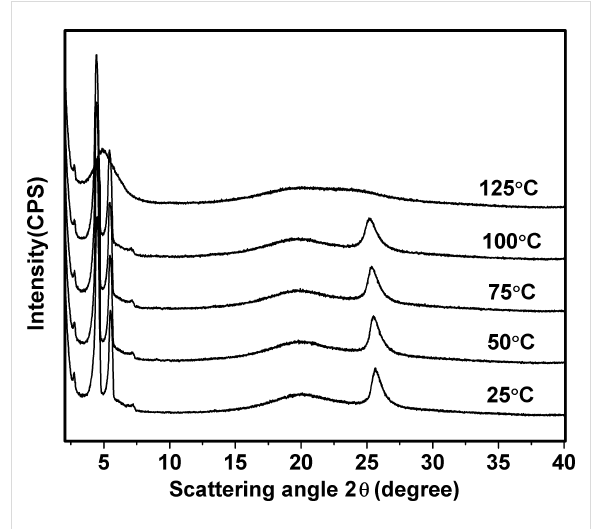
Figure 5: X-ray diffraction profiles of 4 at different temperatures.